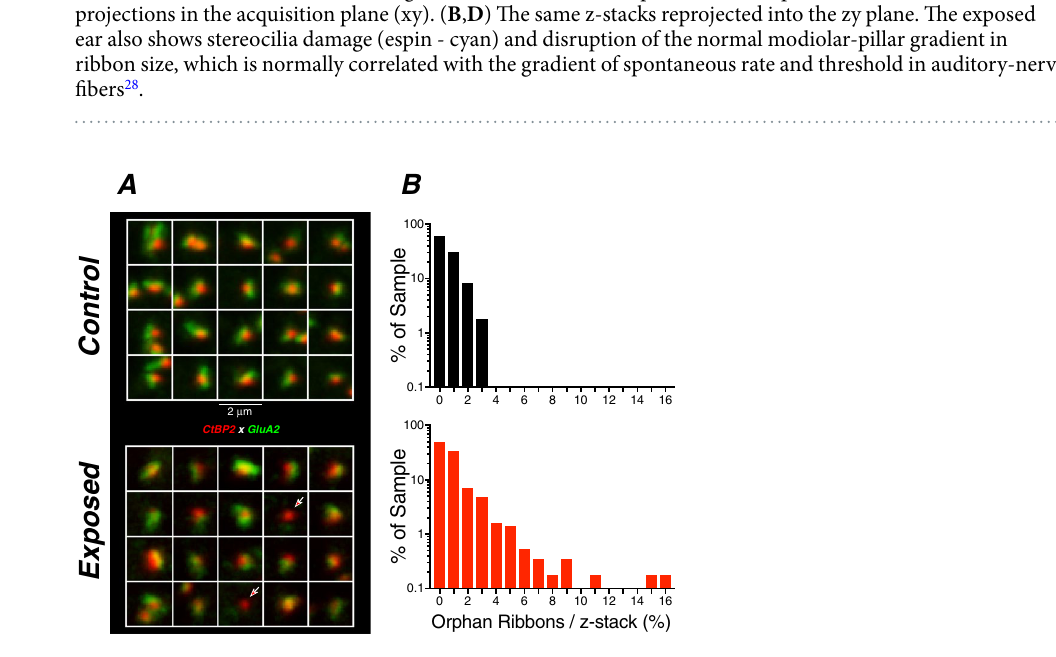
always ruptured after multiple blasts (Fig. 5C,F). For reference, although the blast durations may vary, a peak pressure of 165 dB would be that produced 50 ft from a hand-grenade explosion, and a peak pressure of 175 dB would be comparable to that experienced by a gunner firing an 8-inch howitzer 43 . Our data suggests that ruptur- ing the eardrum is protective to the inner ear because none of the six ears with ruptured eardrums showed sub- stantial loss of cochlear sensory cells (Fig. 5A,C). If the eardrum ruptures, less power will likely be delivered to the inner-ear fluids, since, in the absence of efficient middle-ear transmission, the pressure difference created across the cochlear partition will be reduced 18,44,45 . In another study including chinchillas exposed to repeated blasts, the ears with tympanic-membrane ruptures displayed less cochlear damage than ears with intact tympanic mem- branes 18 . Nevertheless, several human studies report no difference in audiometric thresholds in blast-exposed ears with vs. without eardrum rupture 46,47 . Interestingly, one study did find less sensorineural hearing loss on the ruptured vs. intact sides in cases of unilateral eardrum rupture 3 , despite the likelihood that the ruptured side experienced a higher peak SPL. It may be that intersubject differences in distance from the blast, physical orientation, and intrinsic “toughness” of the inner ear 48 mask such protective effects of eardrum rupture in other human studies. If eardrum rupture is protective, and if the human eardrum is tougher than the chinchilla eardrum, the human inner ear might be more vulnerable to blast-related cochlear injury. However, experiments with continuous-noise exposures suggest that the human inner ear may also be less vulnerable than that of small experimental mammals such as chinchillas 49 .